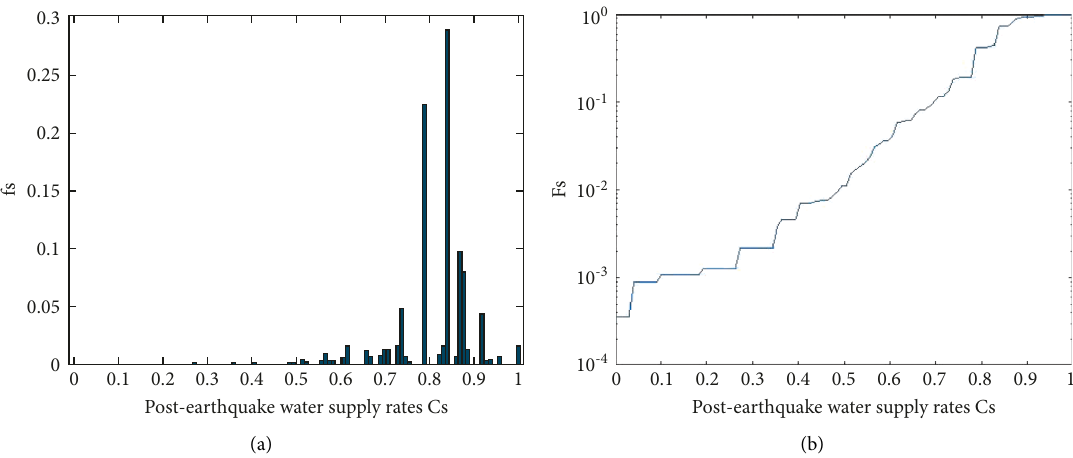
Figure 5: Post-earthquake water supply rate (cast iron pipe) with intermediate liquefaction of intensity IX. (a) Probability mass function. (b) Cumulative distribution